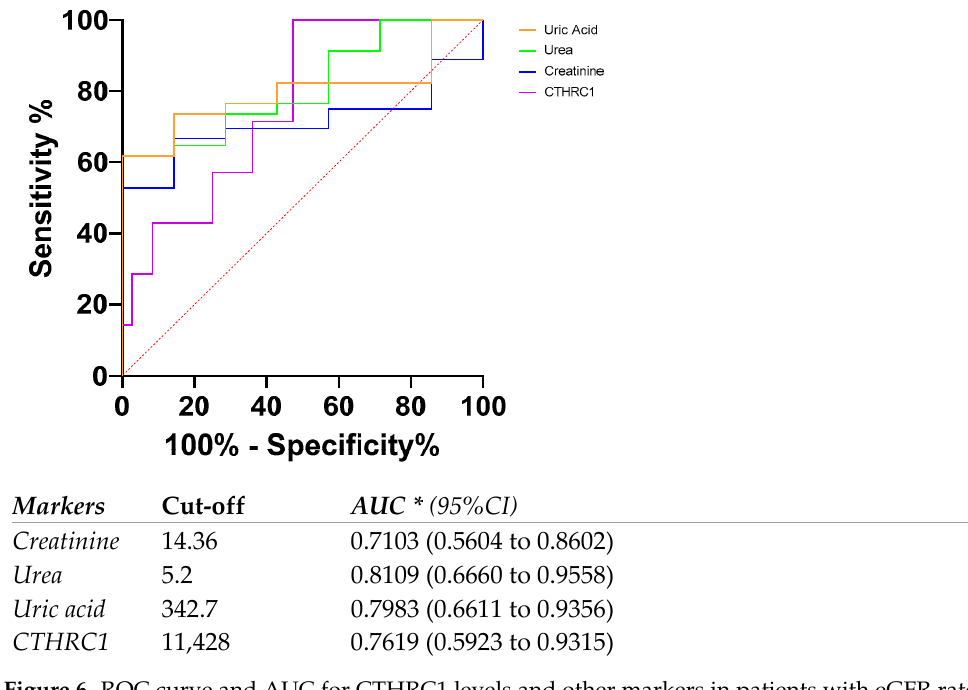
Figure 6 . ROC curve and AUC for CTHRC1 levels and other markers in patients with eGFR rates below 60 mL/min/1.73 m 2 (eGFR < 60). Cut-off values were defined as the value whose sensitivity and specificity are the closest to the value of the area under the ROC curve. * Area under ROC curve lies with 95% confidence interval.